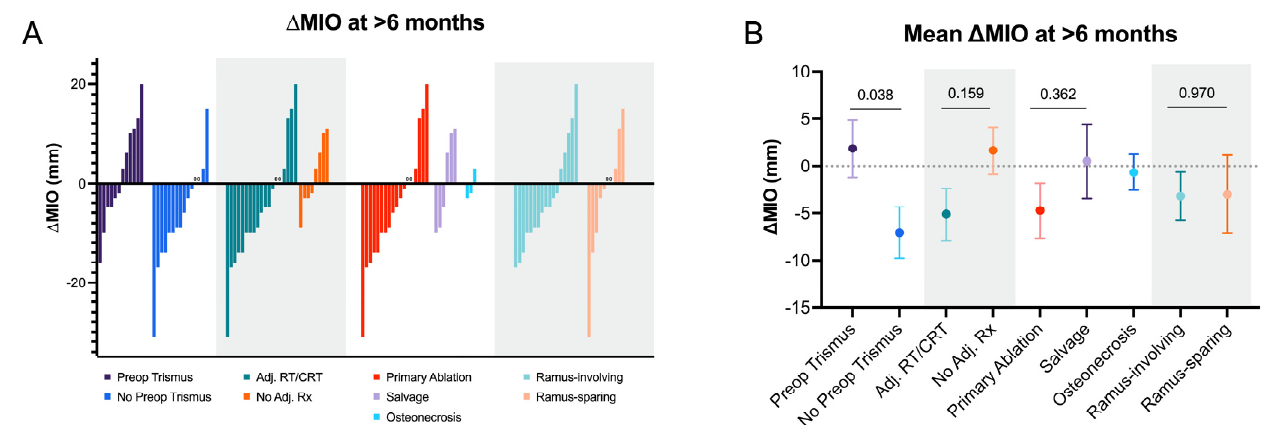
Figure 1. ( A ) Waterfall plot of ∆ MIO for all patients with preoperative MIO and MIO measurement taken >6 months postoperatively ( n = 27), separated by preoperative trismus status, receipt of adjuvant therapy, surgical indication, and ramus involvement of the posterior mandibulotomy; ( B ) mean ∆ MIO > 6 months postoperatively for the same 27 patients when compared by preoperative trismus status, receipt of adjuvant therapy, surgical indication, and ramus involvement of the posterior mandibulotomy.